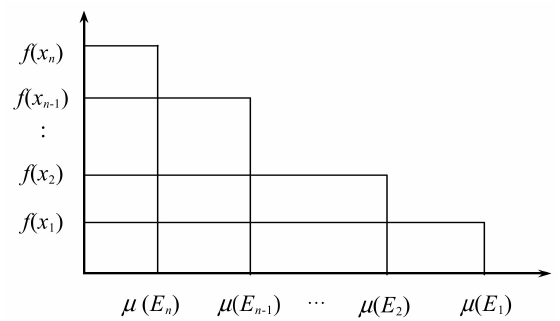
Figure 1. Graphical representation of the Choquet fuzzy